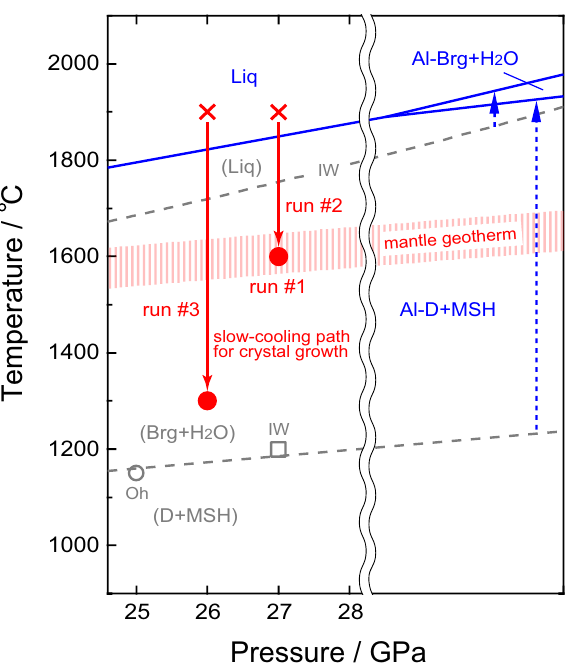
Figure 4. Possible stability relations under water-saturated conditions for the MgSiO 3 system (dotted grey lines) and for the Al 2 O 3 -bearing MgSiO 3 system (solid blue lines) inferred from the present results and the previous studies 6,26 . For the Al 2 O 3 -bearing MgSiO 3 system, about 8 mol% of Al 2 O 3 component is assumed implicitly. Phase abbreviations: D, phase D; Brg, MgSiO 3 bridgmanite; Al-D, Al-bearing phase D; Al-Brg, Al-bearing MgSiO 3 bridgmanite; Liq, liquid; MSH, residual MgO–SiO 2 –H 2 O components. Stability fields with and without parentheses denote those for the Al 2 O 3 -free and the Al 2 O 3 -bearing systems, respectively. The open grey circle, Oh, and the open grey square, IW, show stable existences of D + MSH (Ref. 6 ) and Brg + H 2 O (Ref. 26 ) in